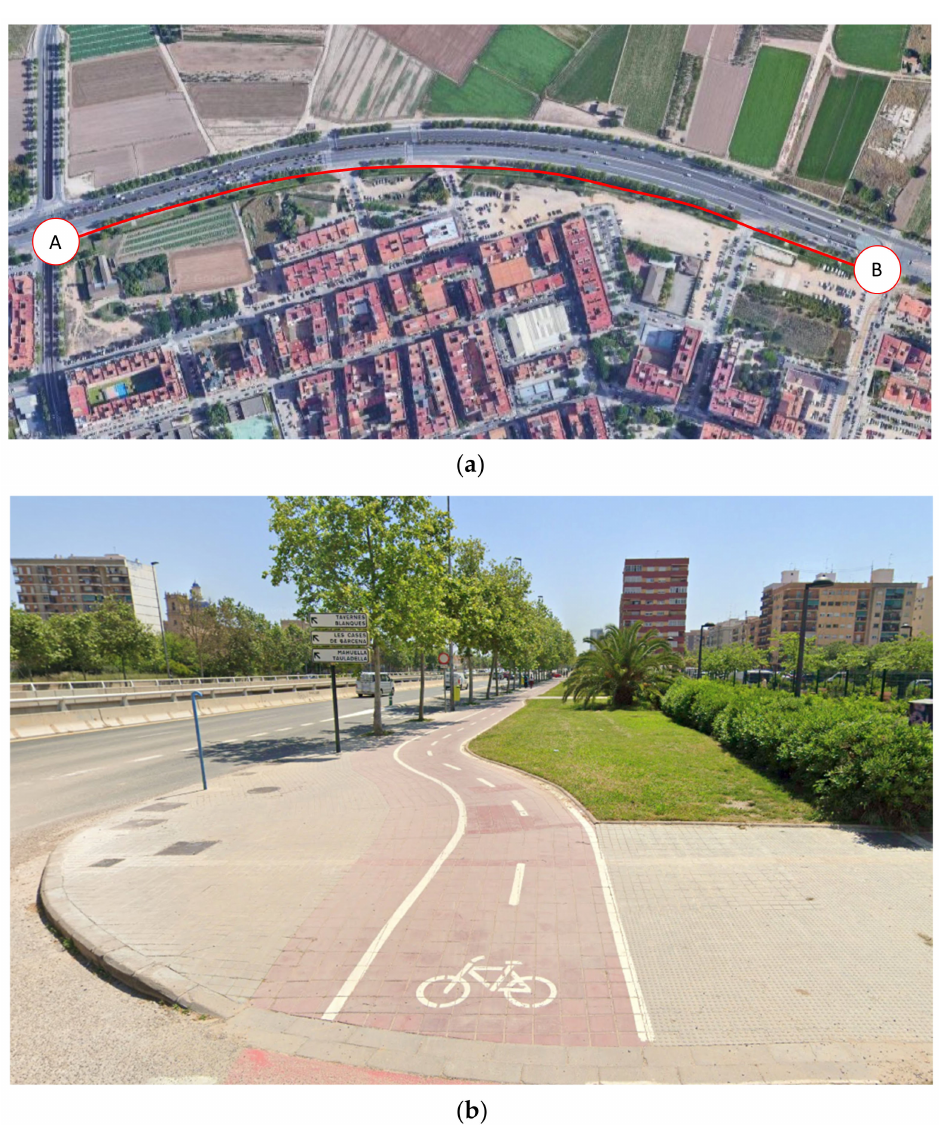
Figure 9. Case study location: ( a ) aerial view (A: start point; B: final point) and ( b ) bike lane